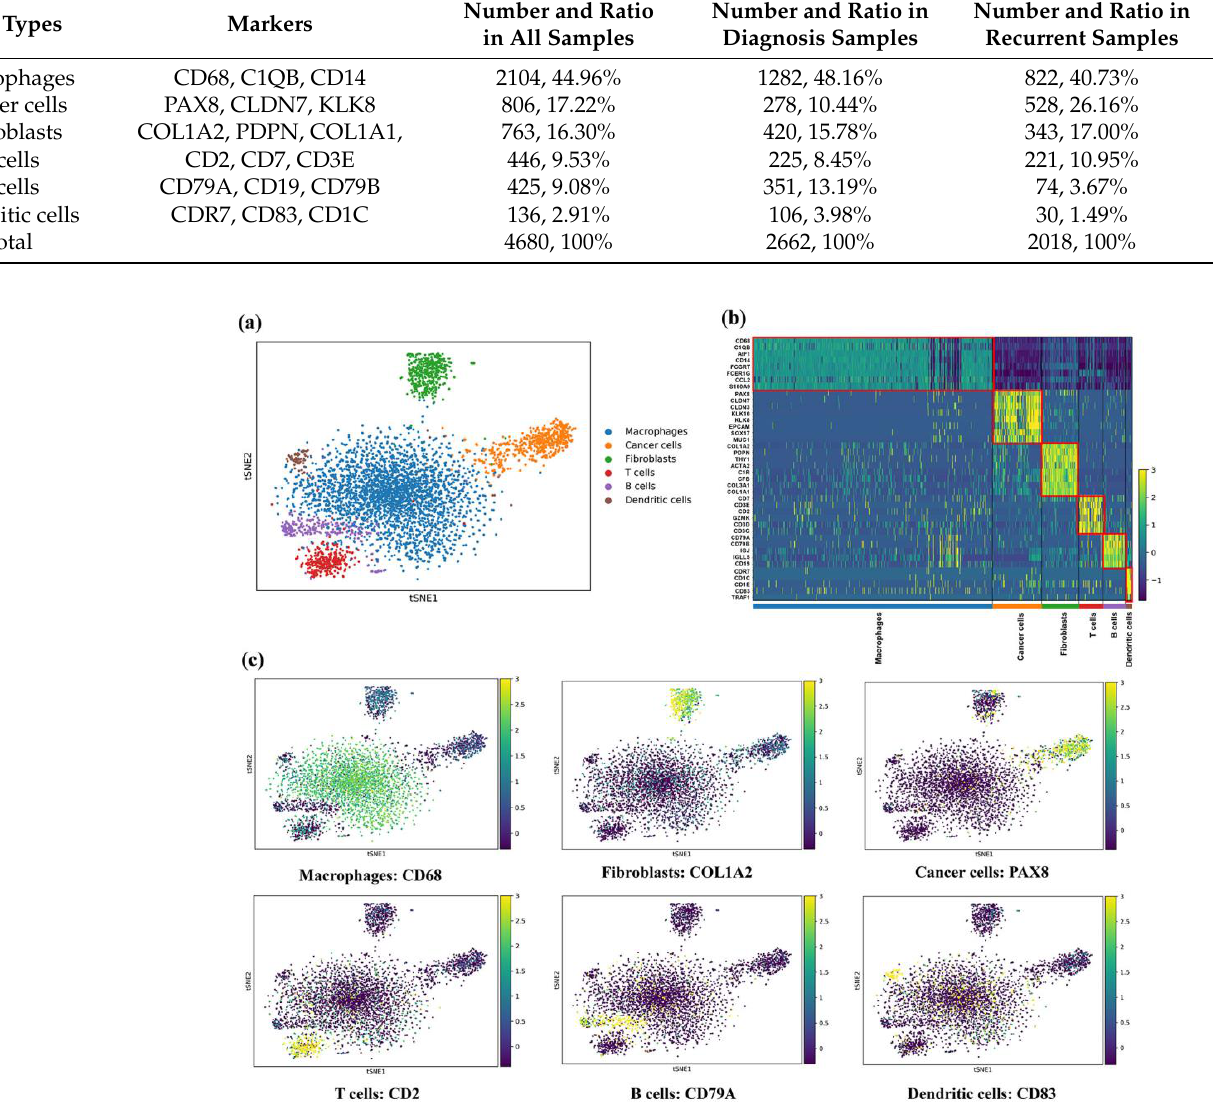
Figure 2. Overview of single-cell landscape for malignant ascites of EOC. ( a ) 4680 single-cells and six cell types were identified, colored by cell type. ( b ) Heatmap of marker genes for each cell type. ( c ) T-SNE map showing canonical markers for six cell types: CD68 for macrophages; COL1A2 for fibroblasts; PAX8 for cancer cells; CD2 for T cells; CD79A for B cells; CD83 for dendritic cells.